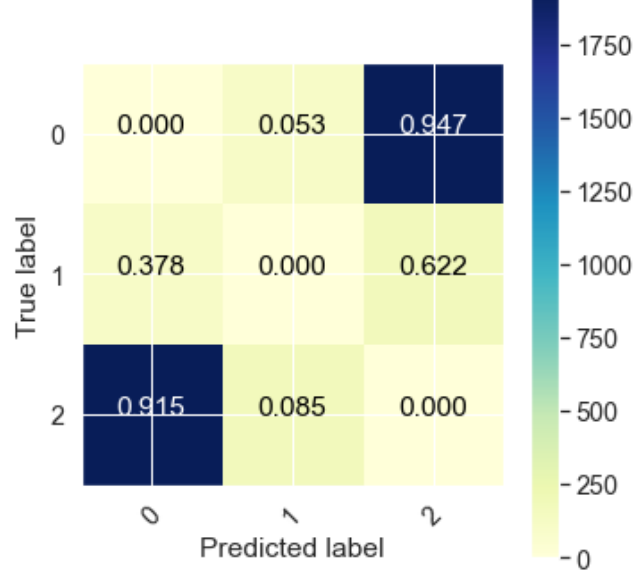
Figure 2. Labels causing bi-disagreements. (Labels: 0: Agree, 1: Disagree, 2: